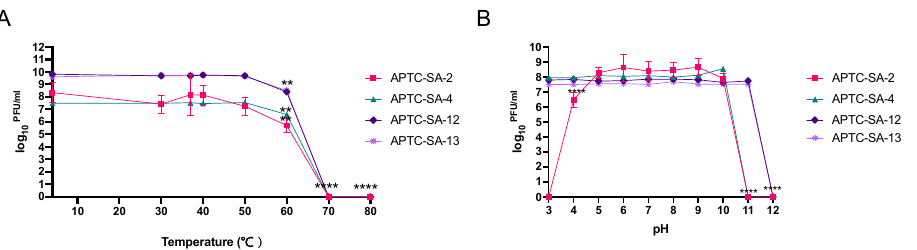
Figure 1. S. aureus phages’ temperature and pH stability tests. APTC-SA-2, APTC-SA-4, APTC-SA-12, and APTC-SA-13 phage stability testing measured in log 10 PFU/mL . ( A ) Phage stability at different temperatures (4, 30, 37, 40, 50, 60, 70, and 80 ◦ C). ( B ) Phage stability at different pHs (3, 4, 5, 6, 7, 8, 9, 10, 11, and 12). The experiment was repeated 3 times. Bars represent standard deviations (SD). **, p < 0.01; ****, p < 0.0001.